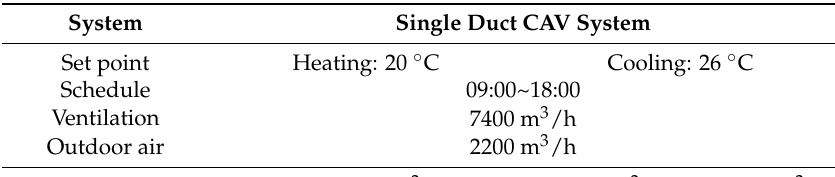
Table 10. Input conditions of TRNSYS simulation.